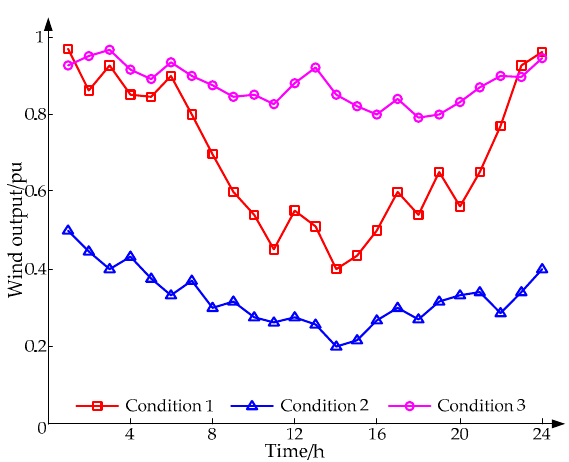
Figure 5. Day-ahead forecast of the WP output under different working conditions.